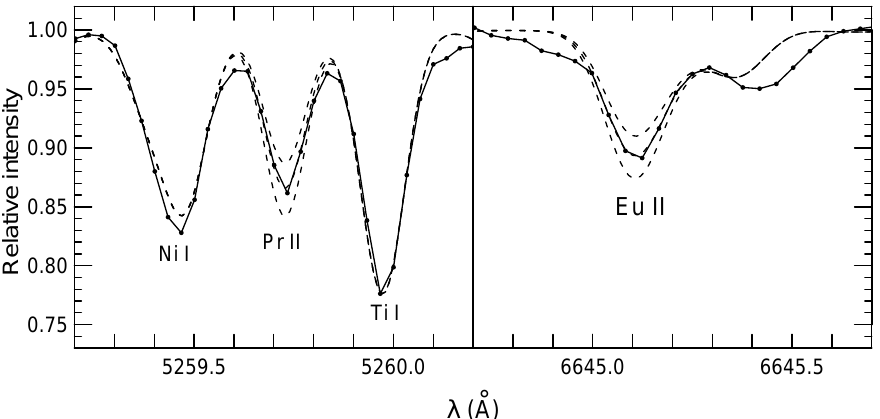
Fig. 7. Synthetic spectrum fit to the Eu ii line at 6645.10 ˚A. The observed spec- trum is shown as a solid line. The dashed lines are synthetic spectra with [Eu = Fe] = 0 : 02, 0.12 and 0.22